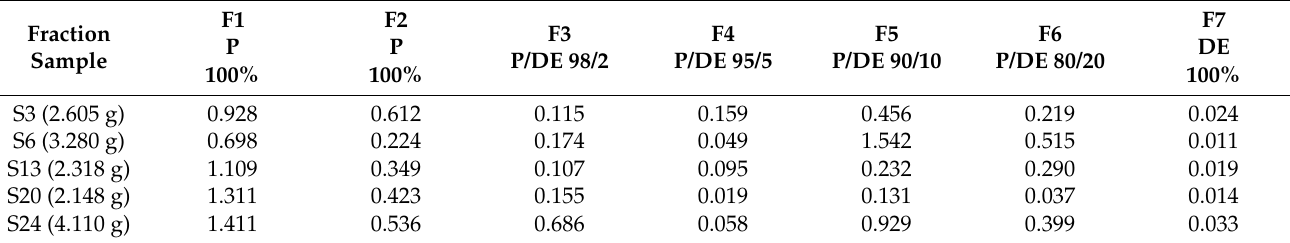
Table 6. Fractions obtained from column